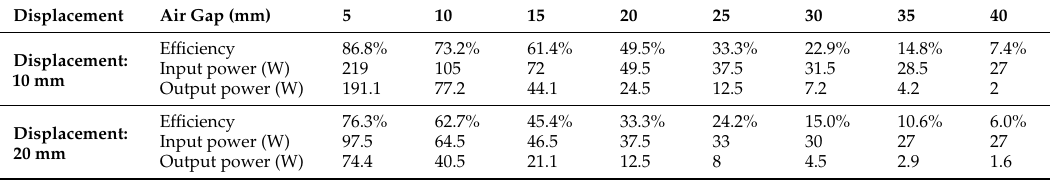
The dislocation effect of the IPT system with varied air gap is given in Table 5. Table 5 is for dislocations of 10 mm and 20 mm, respectively. The performances of the IPT system are increased by decreased